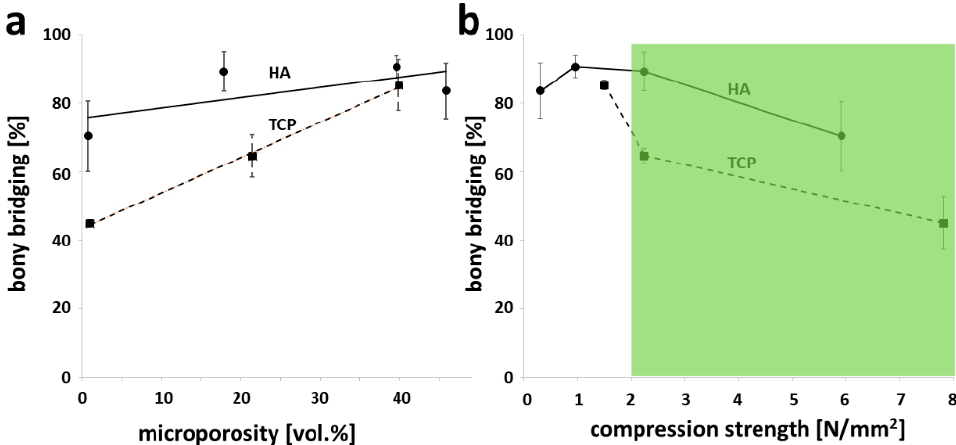
Figure 3. Comparison of osteoconductivity in relation to microporosity and compression strength between otherwise identical HA- and TCP-based scaffolds. The results for TCP-based scaffolds produced with the identical stl-file were generated and reported earlier [10]. ( a ) Osteoconductivity related to microporosity of test samples; ( b ) osteoconductivity related to compression strength of the partially sintered scaffolds. The values are displayed as mean ± standard deviation. The range for cancellous bone (2–12 N/mm 2 ) depicted in the green shaded area was taken from [34].